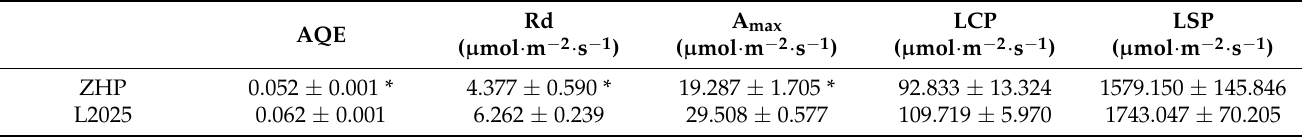
Data are means ± SE ( n = 3). Values followed by * indicate significant difference within the same column according to Student’s t -test ( p <